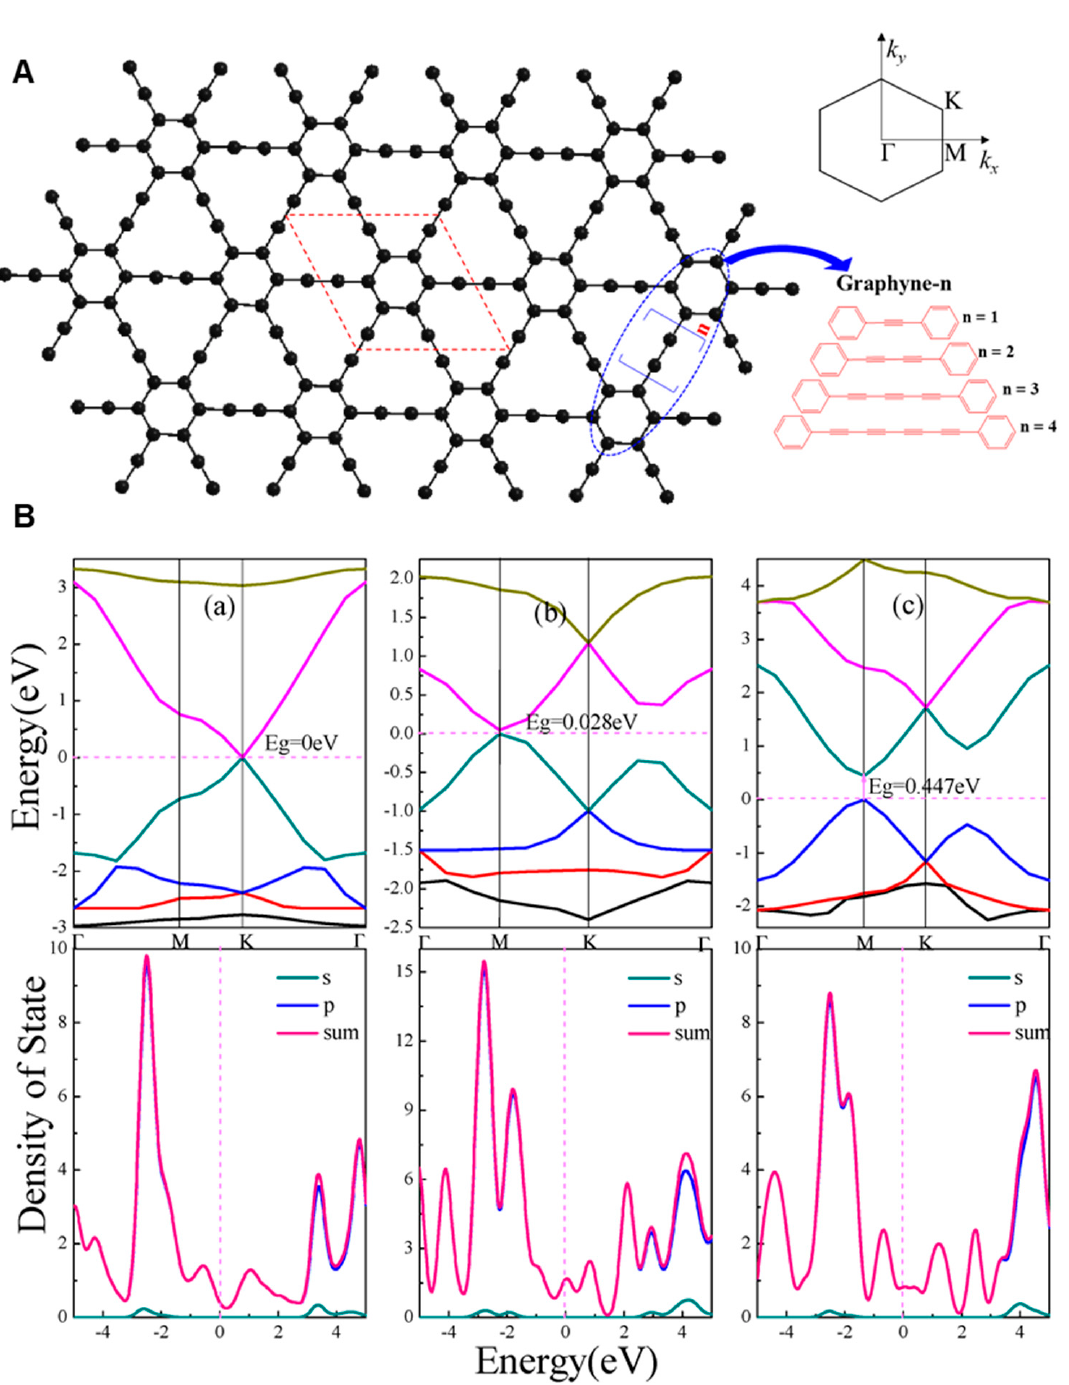
Figure 12. Illustration of graphyne-n structures. The red parallelogram shows the unit cell of GYs. The Brillouin zone is shown in the upper-right, and various acetylenic linkers are shown in the bottom-right ( A ); ( B ) band gaps (Eg) and density of states (DOS) of α -graphyne ( a ), β -graphyne ( b ), and γ -graphyne ( c ). s and p describe the partial densities of states of the s and p orbitals in carbon atoms, respectively. The sum of both elements gives a value of the total density of states. Reproduced with permission [123]. Copyright 2018,